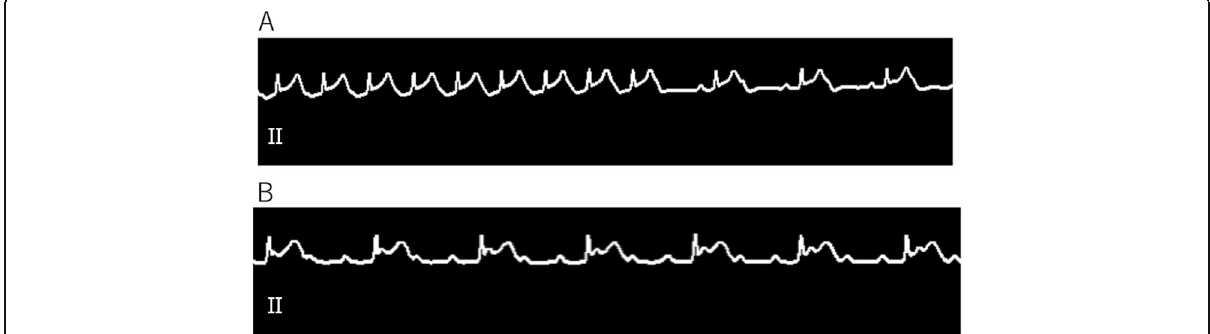
Fig. 2 Electrocardiogram monitor showing ST-segment elevation and bradycardia after initiation of laryngoscopy ( a ). Complete atrio-ventricular block with ST-segment elevation is observed (P waves with a regular P-to-P interval, QRS complexes with a regular R-to-R interval, and variable PR interval) on the electrocardiogram monitor ( b